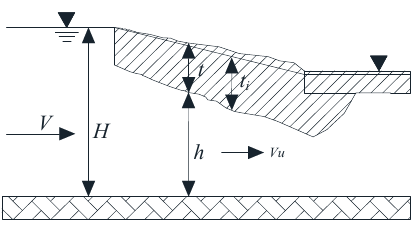
Figure 4. Schematic diagram of an ice jam.